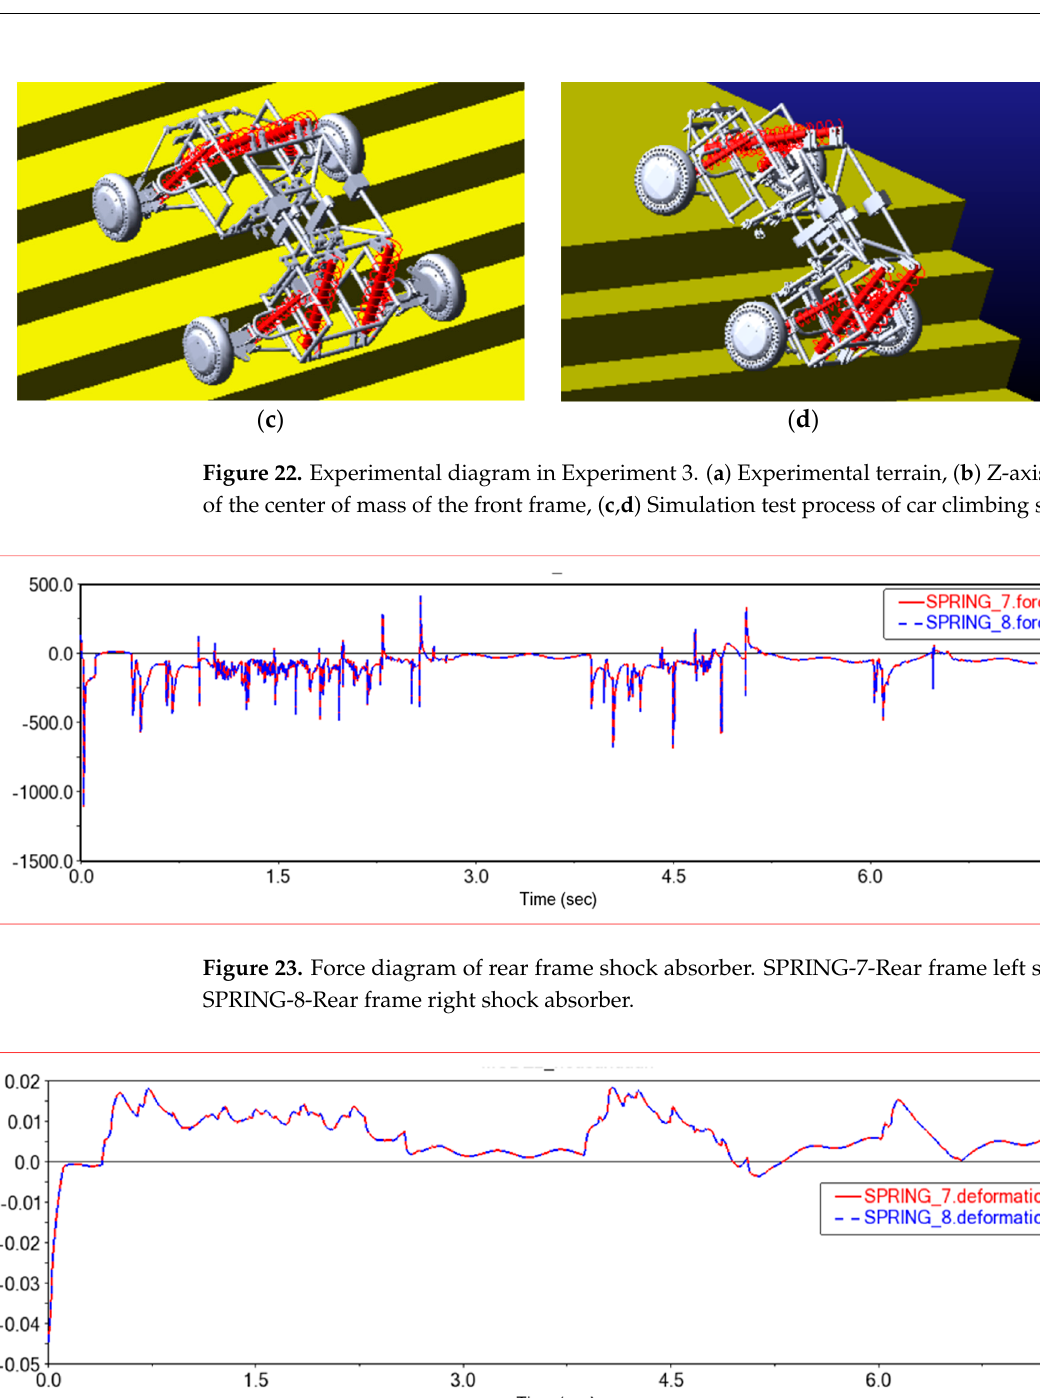
( d ) Figure 22. Experimental diagram in Experiment 3. ( a ) Experimental terrain, ( b ) Z-axis displacement of the center of mass of the front frame, ( c , d ) Simulation test process of car climbing stairs. Figures 23 and 24 show the force curve and deformation curve of the two shock ab-